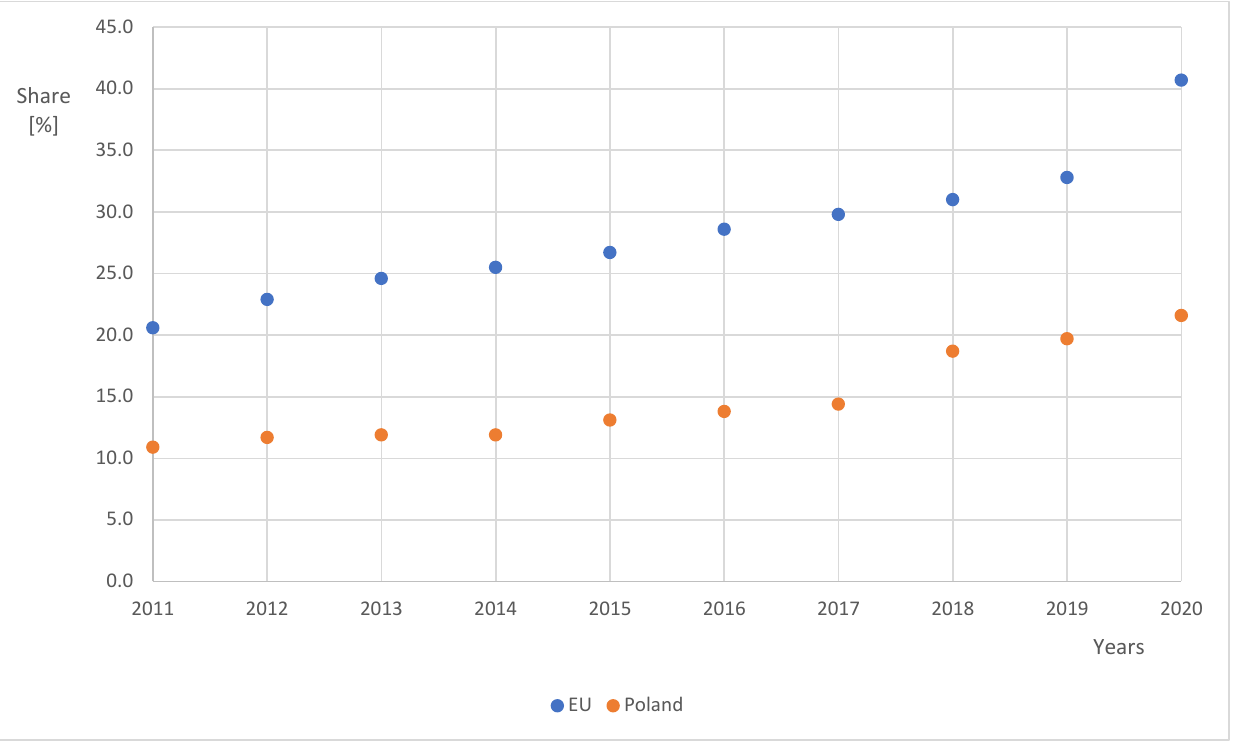
Figure 5. Share of energy from renewable sources in the EU and Poland, according to Table 18 (own elaboration).